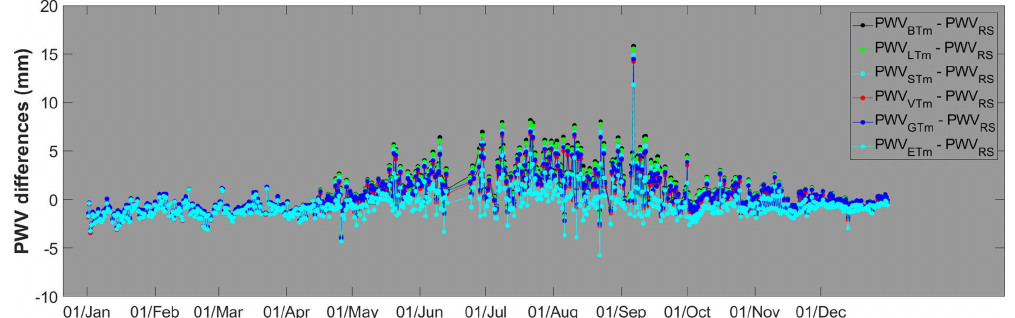
Figure 14. PWV differences of the PWV BTm , PWV LTm , PWV STm , PWV VTm , PWV GTm and PWV ETm compared with the PWV RS at the NIRL station in the year 2016. PWV unit is